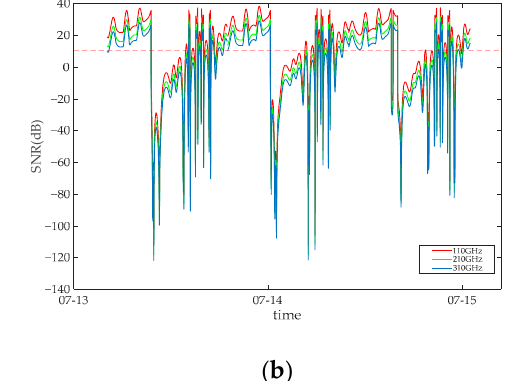
Figure 13. Variation of signal-to-noise ratio with time in inter-satellite terahertz communication sys- tem: ( a ) uplink terahertz communication link for LEO-GEO; ( b ) downlink terahertz communication link for GEO-LEO.